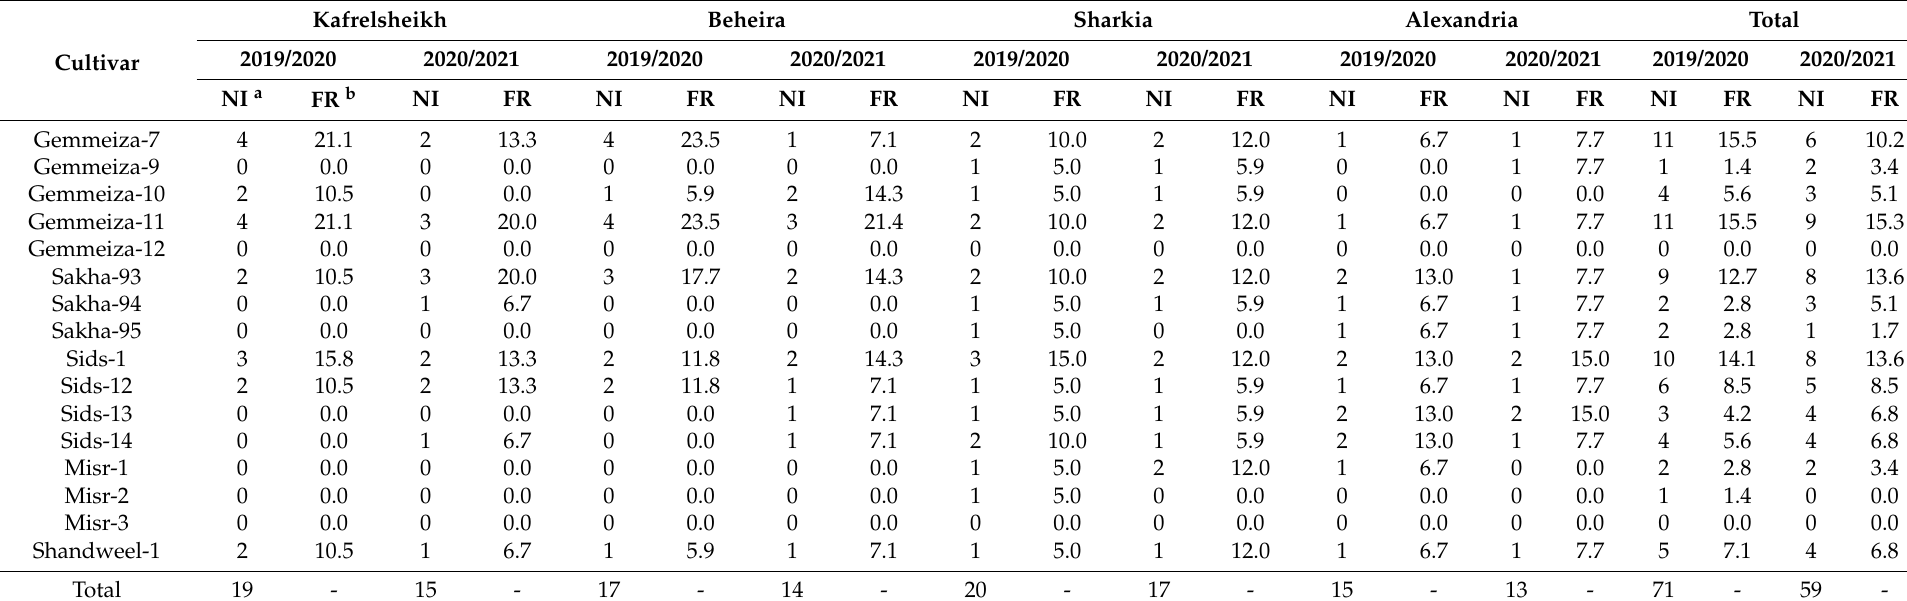
Table 3. The number of isolates and frequency (%) of Egyptian wheat cultivars in different governorates, during 2019/20 and 2020/21 growing seasons.